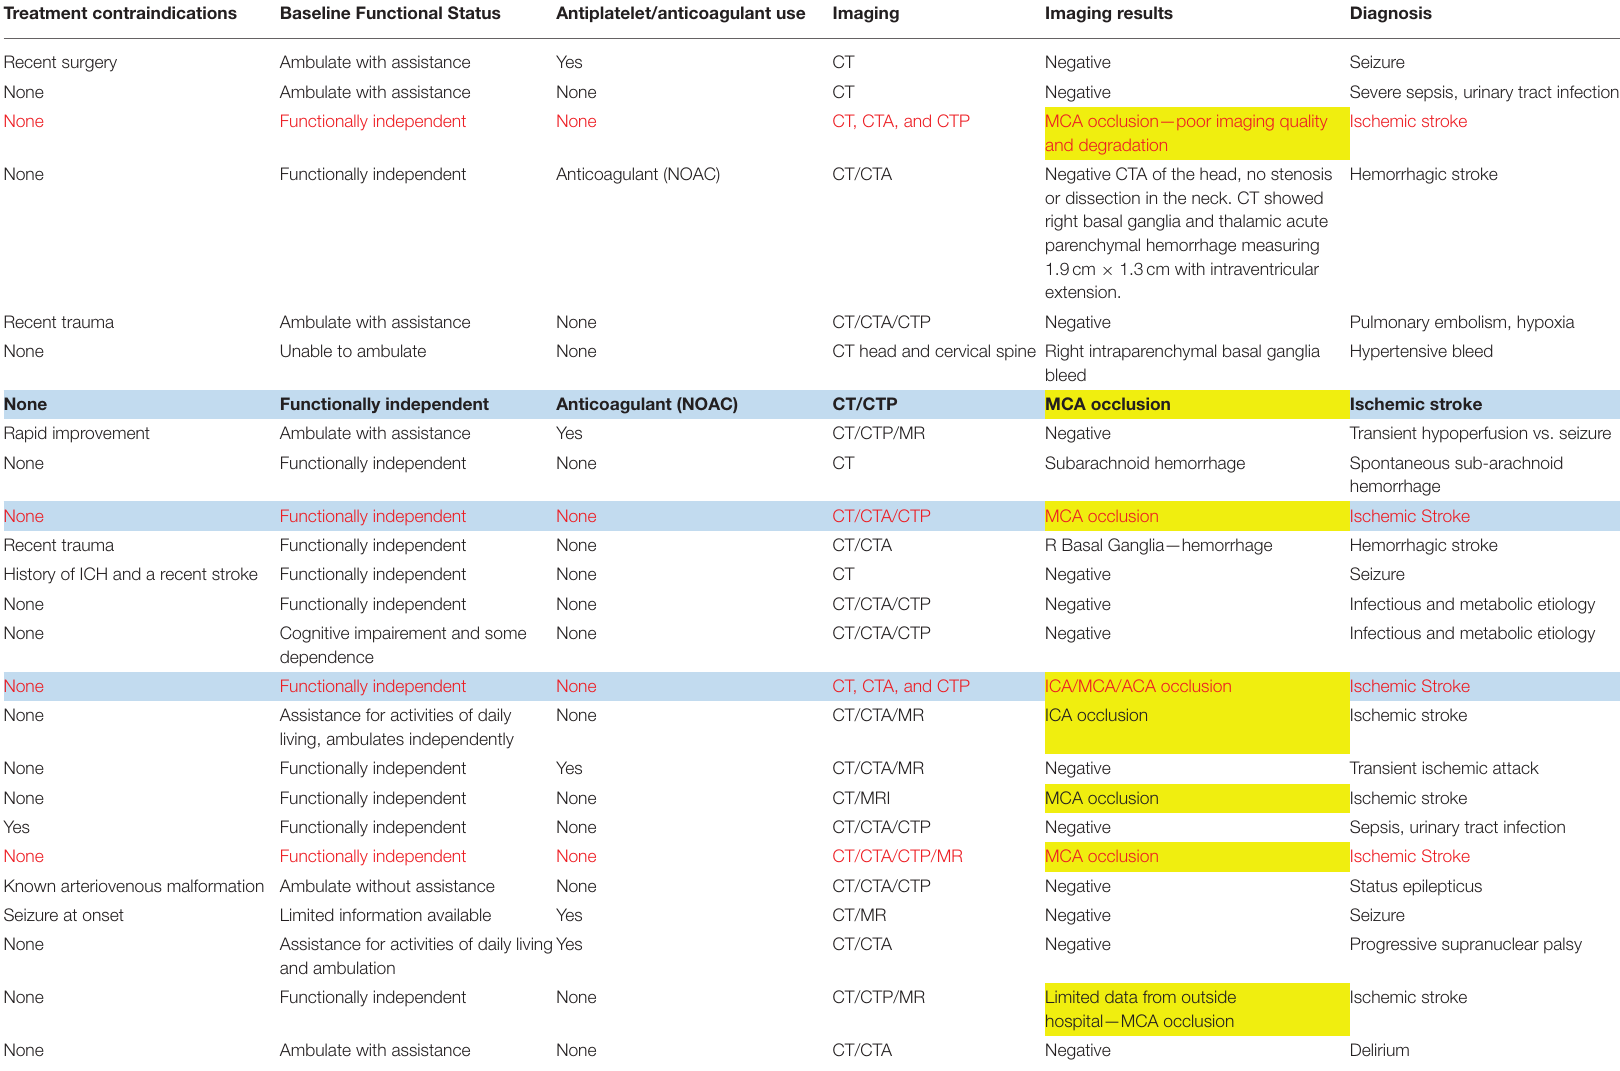
TABLE 1 | Medical history, imaging, and discharge diagnosis of suspected stroke patients transported by emergency medical services. Treatment